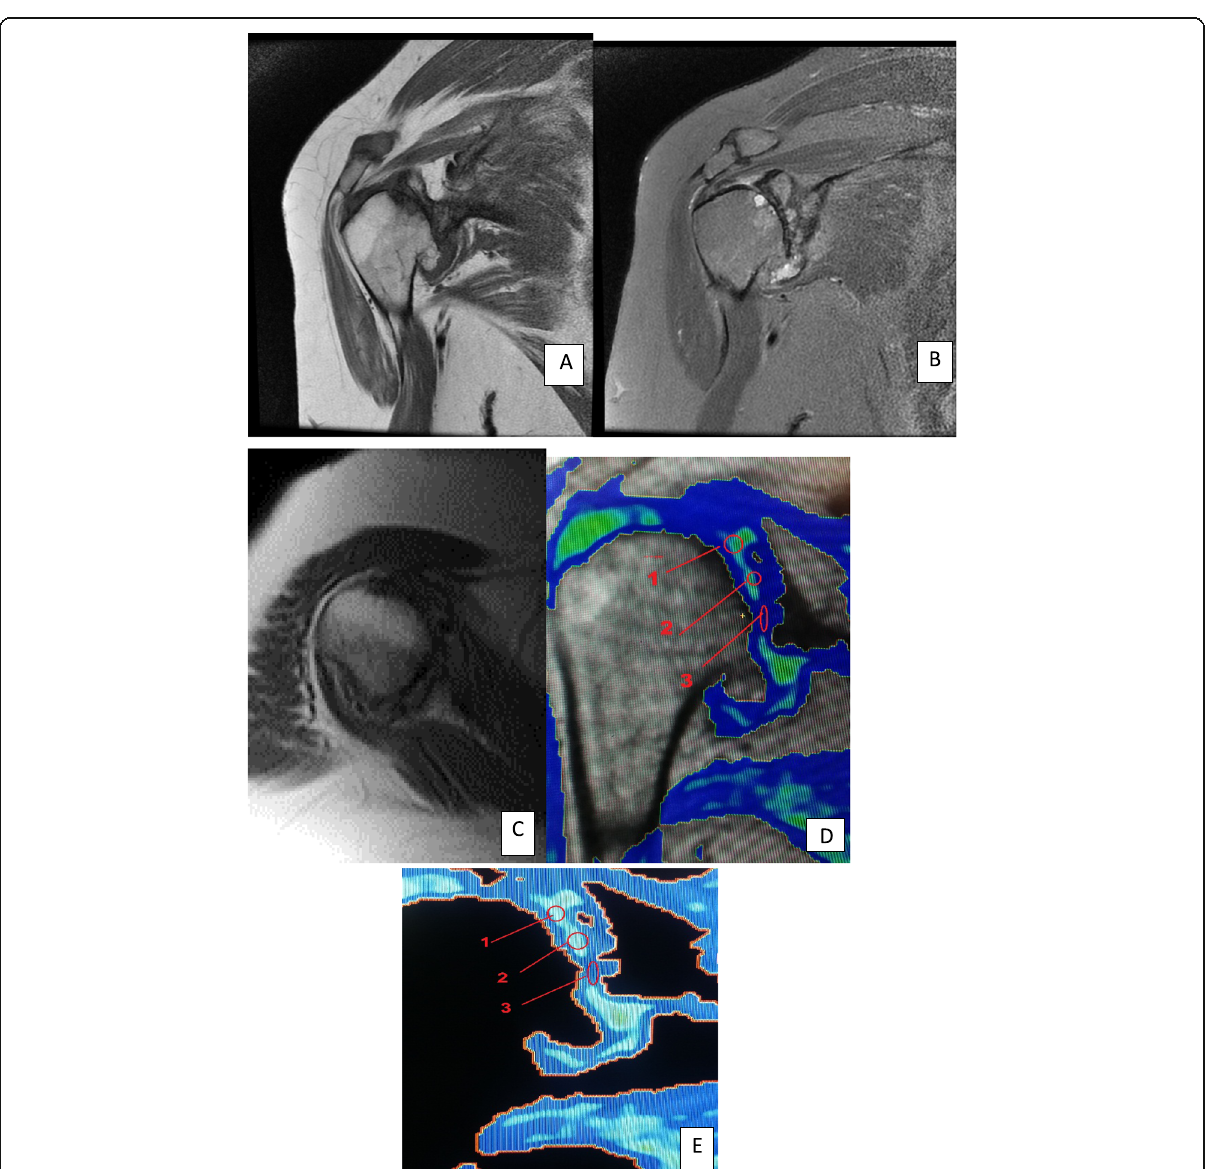
Fig. 3 a Coronal T1 WI. b Coronal proton density (PD) WI c An axial T2 WI revealed advanced secondary osteoarthritic changes in form of narrowed joint space, marked osteophytosis, and irregular articular surface (grade III). d T2 colored mapping. e A processed image showed T2 values were 75 ms, 70 ms, and 69 ms for the glenoid zone (3), mid zone (2), and humeral surface (1) respectively (red